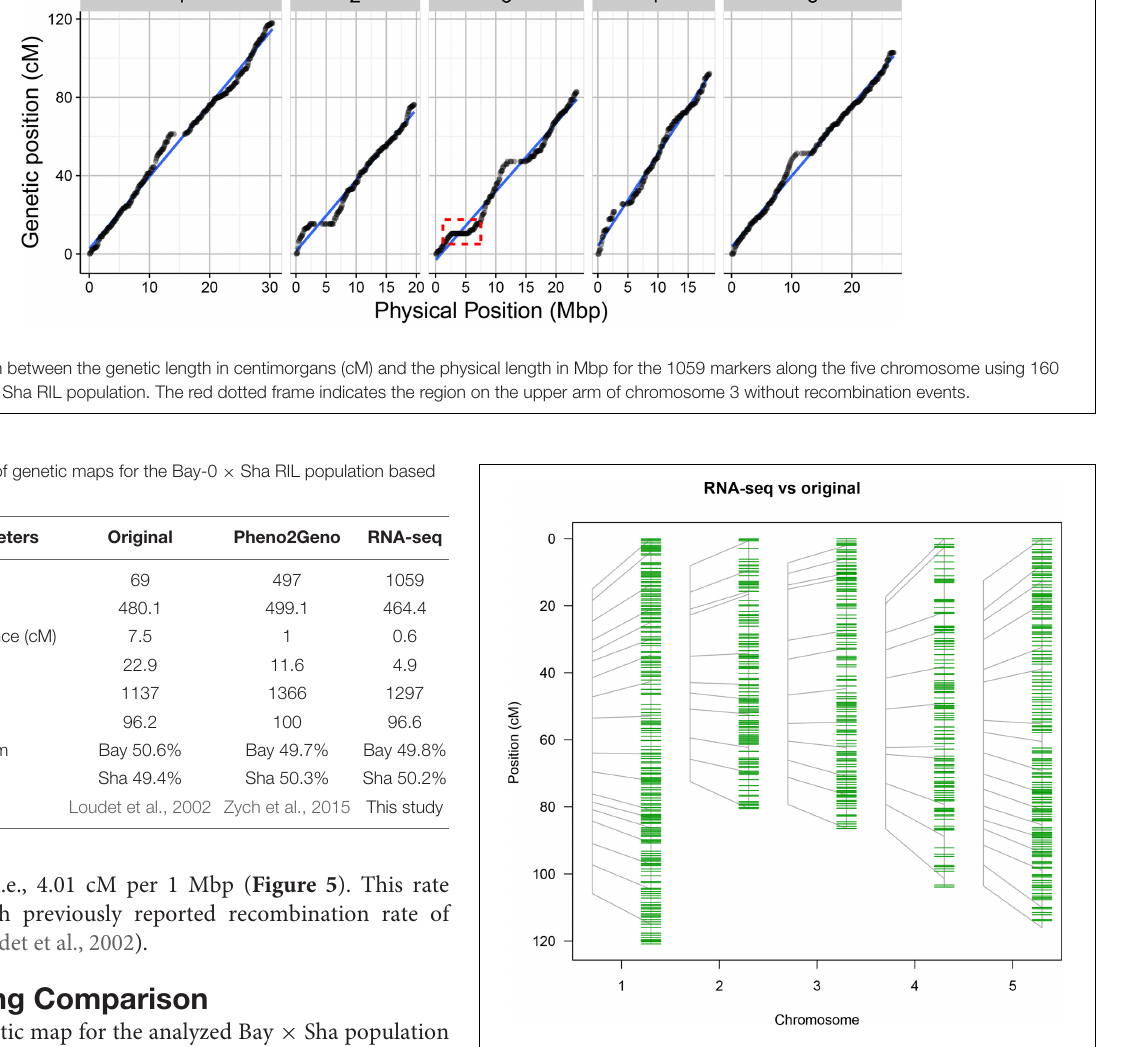
FIGURE 6 | Saturation of the original map (69 PCR-based markers) with RNA-seq-derived markers. The position of the original markers is represented on the left of each chromosome in gray and linked to their position in the saturated map (green